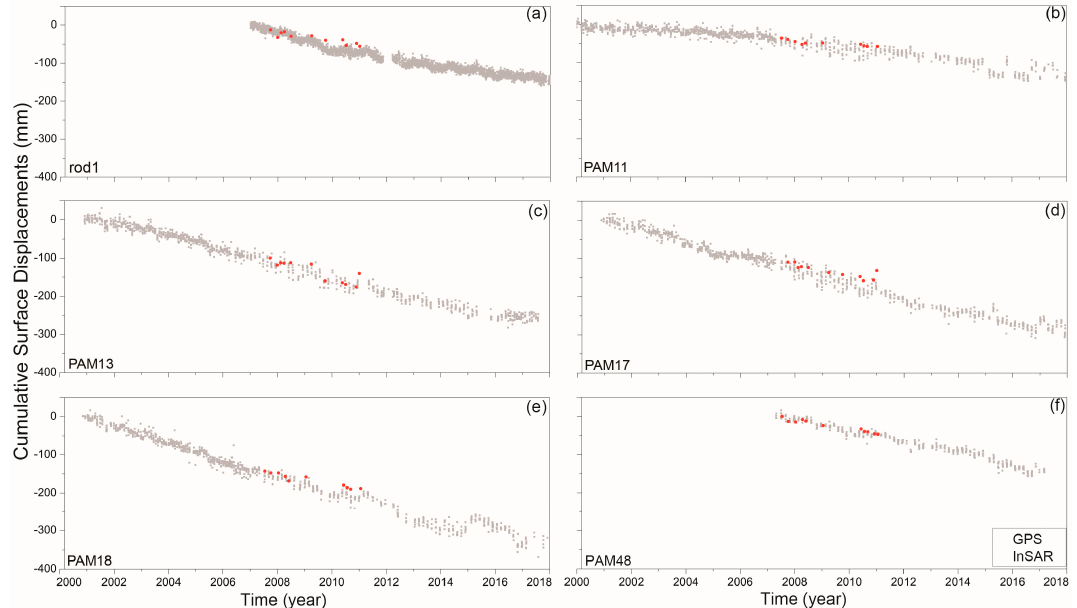
Figure 7. Comparison between InSAR-mapped time-series ground surface displacement and GPS observations at 6 stations.